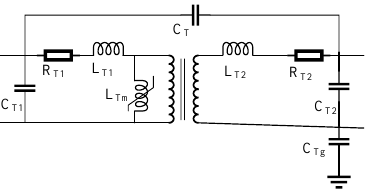
Figure 5. High-frequency saturation equivalent circuit of the transformer. Table 1. Parameters of high-voltage rectifier.